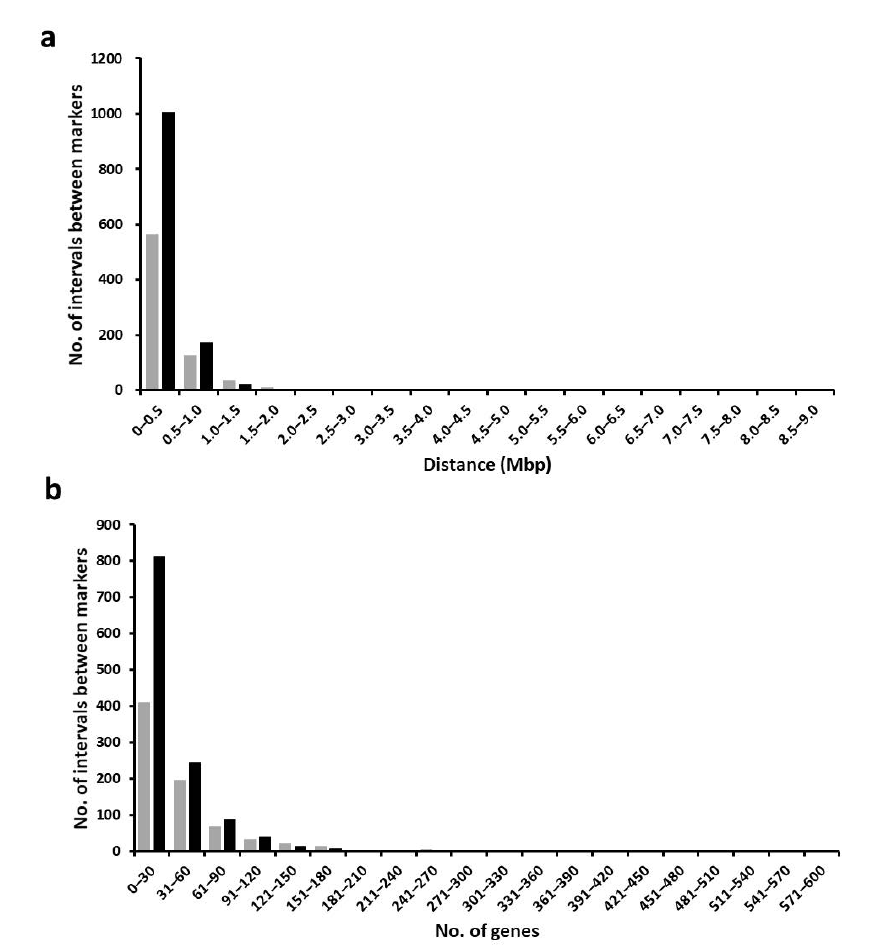
Figure 4. Histogram of distances and number of genes between markers. ( a ) Histogram of distances between markers. ( b ) Histogram of number of genes between markers. Grey bars indicate 771 KASP markers while black bars indicate 1225 KASP